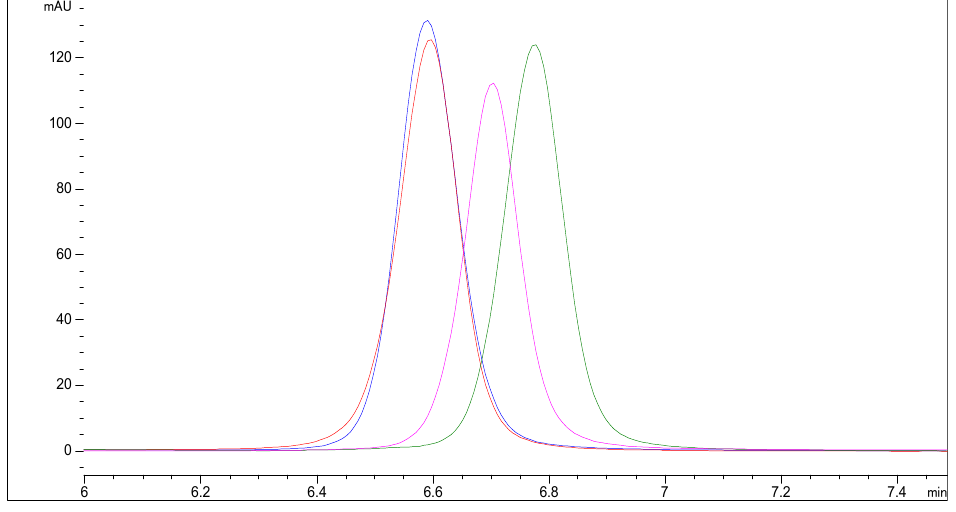
Figure A3. The effect of NaCl concentration in the mobile phase on Lf peak shape: −− 0.0 M NaCl, −− 0.05 M NaCl, −− 0.25 M NaCl, and −− 0.5 M NaCl. Separation was performed on Zorbax 300SB-C3 column at 35 °C using 0.1% TFA and NaCl in water (A) and acetonitrile (B) as a mobile phase at a flow rate of 1.0 mL/min. The gradient program is described in Section 2.2.